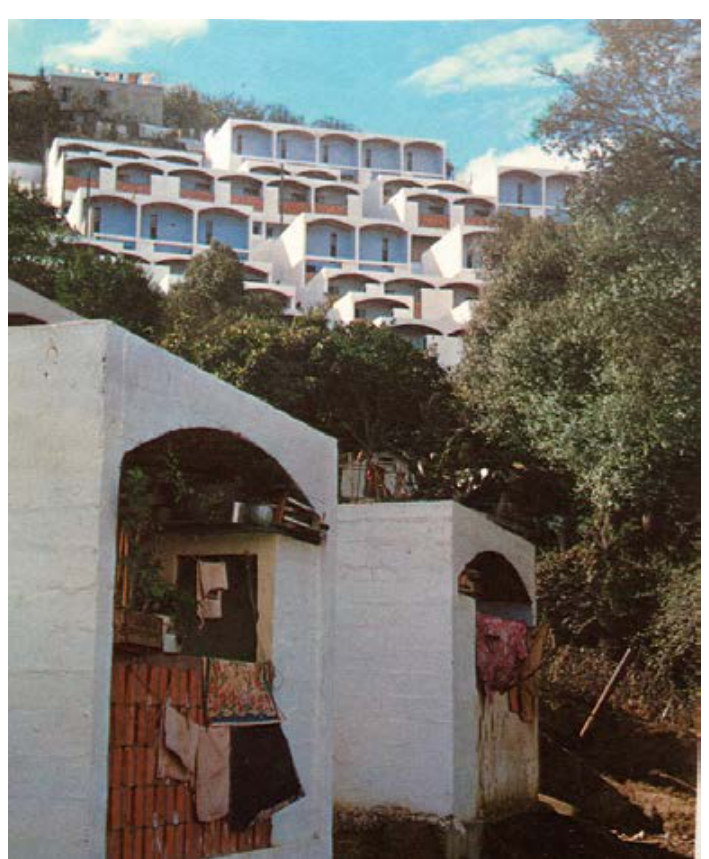
Figure 4. Djenan El Hassan housing scheme